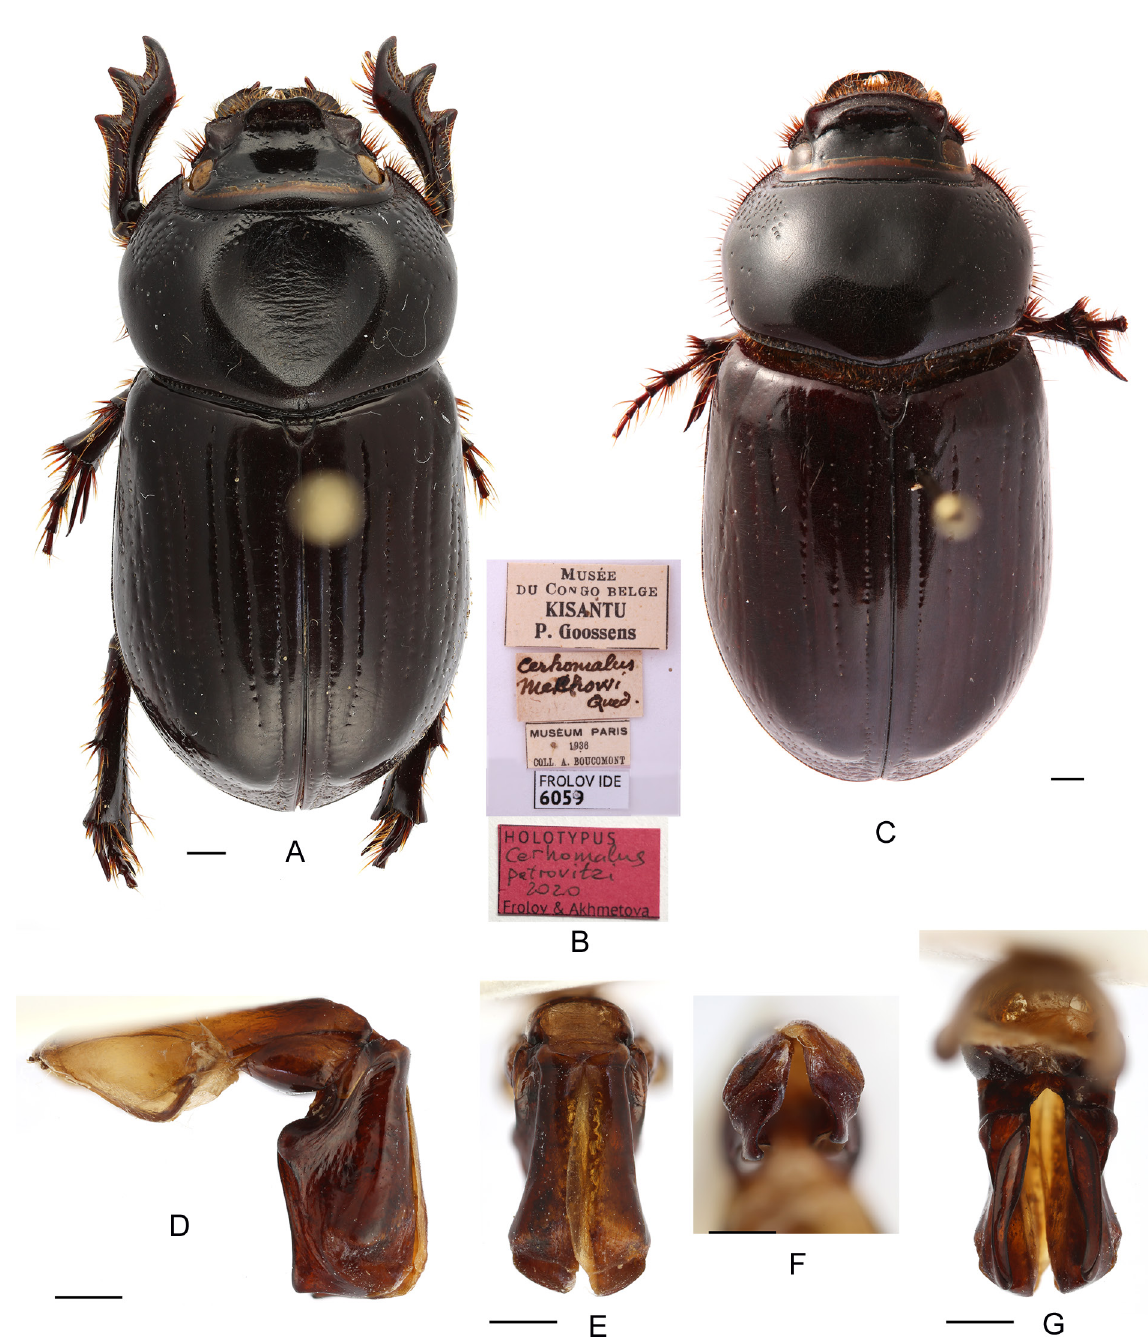
Fig. 3. Cerhomalus petrovitzi sp. nov. A–B, D–G . Holotype, ♂ (MNHN). C . Paratype, ♀ (RMCA). A, C . Habitus in dorsal view. B . Labels. D . Aedeagus in lateral view. E . Parameres in dorsal view. F . Parameres in apical view. G . Parameres in ventral view. Scale bars = 1.0